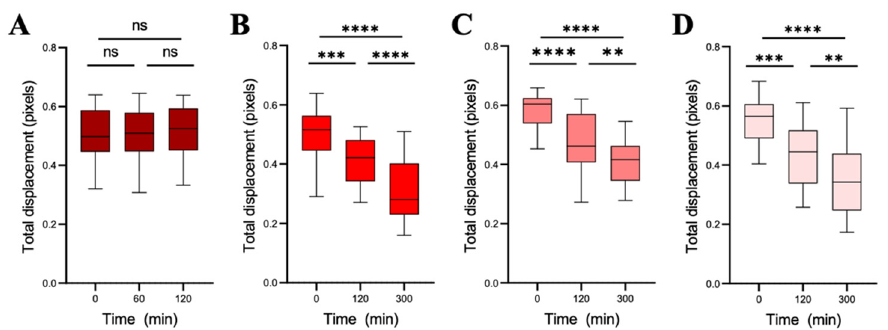
Figure 8. The average cellular nanomotion of 20 cells of C. albicans CAF2-1 wild-type strain. The total displacement of 20 cells was analysed during ( A ) 2 h of growth in a YPD medium (control) and during 5 h of caspofungin treatment at ( B ) 0.5 µg/mL, ( C ) 1 µg/mL, and ( D ) 100 µg/mL. Wilcoxon test: **** p < 0.0001; *** p < 0.001; ** p < 0.01; ns: not signi fi cant.